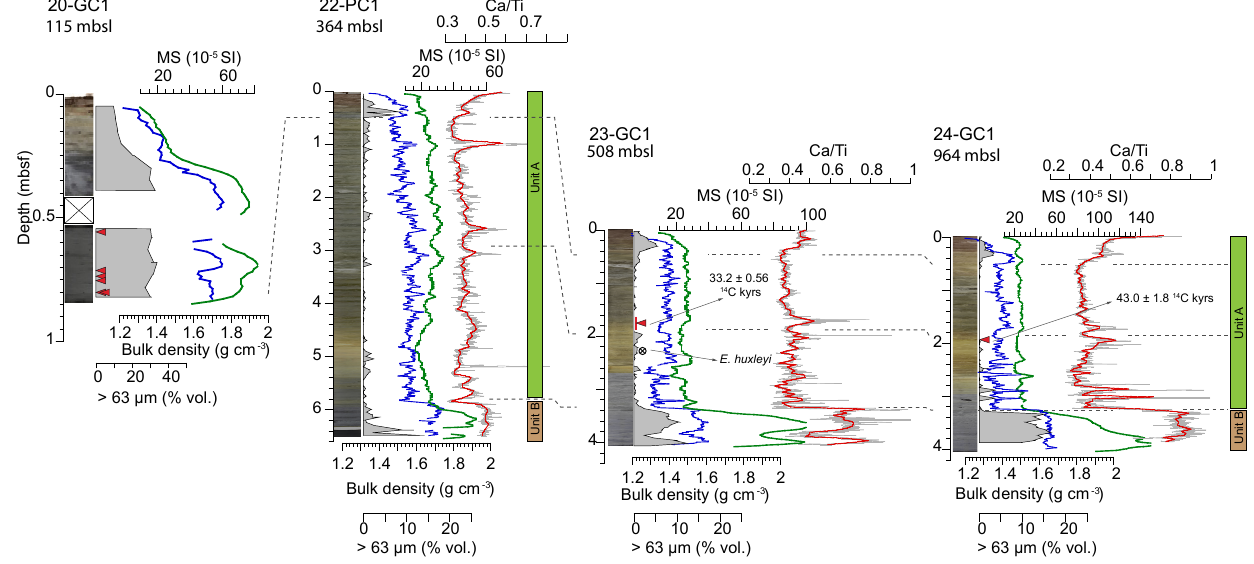
Figure 9. Stratigraphic correlation of core 20-GC1, 22-PC1, 23-GC1 and 24-GC1, based on MSCL, XRF-scanning, digital images and radiocarbon dating results. The acoustically laminated sediments of Unit 3 (Figs. 4 and 5) are represented by sedimentary Unit A in cores 22-PC1, 23-GC1 and 24-GC1. These undisturbed sediments overlie the glacial diamict of Unit B, which corresponds to acoustic Unit 4. The base of Unit A is older than ∼ 50calkyrBP based on results from radiocarbon dating. Core 20-GC1 was obtained from 115mb.s.l. It was taken from an area of the shelf that would have been exposed during the last glacial cycle. Radiocarbon dates from below 55cm in the core indicate a deglacial age for the lowermost sediments. These likely correlate with the slightly coarser-grained interval seen in the upper few decimeters of cores 22-PC1, 23-GC1 and